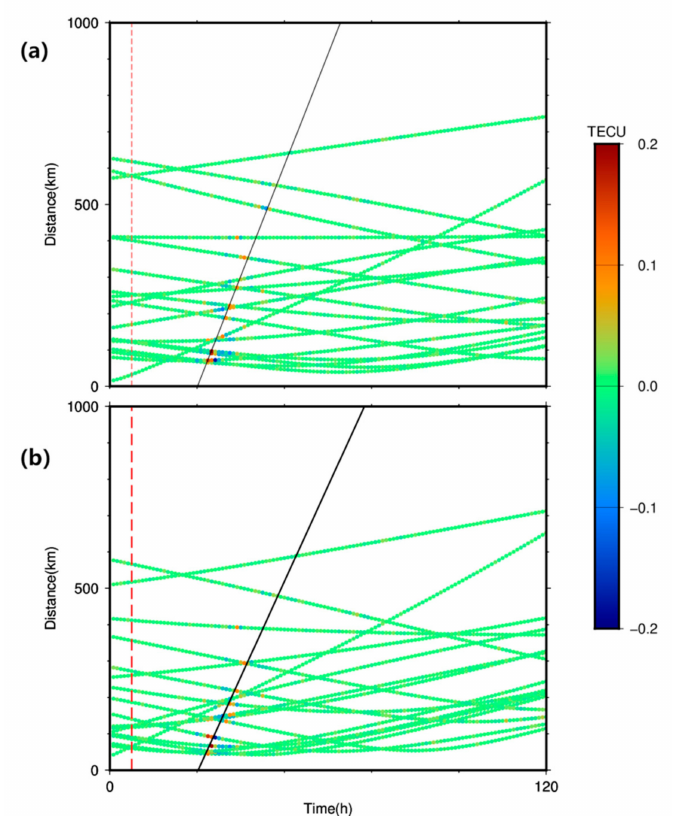
Figure 16. Travel time of ∆ STEC as a function of time and the epicenter distance. ( a ) Shell-1 model; ( b ) Shell-2 model. The red dashed line represents the occurrence of the earthquake, and the black line represents the fitted trend line according to the peak point of the coseismic ionospheric disturbances